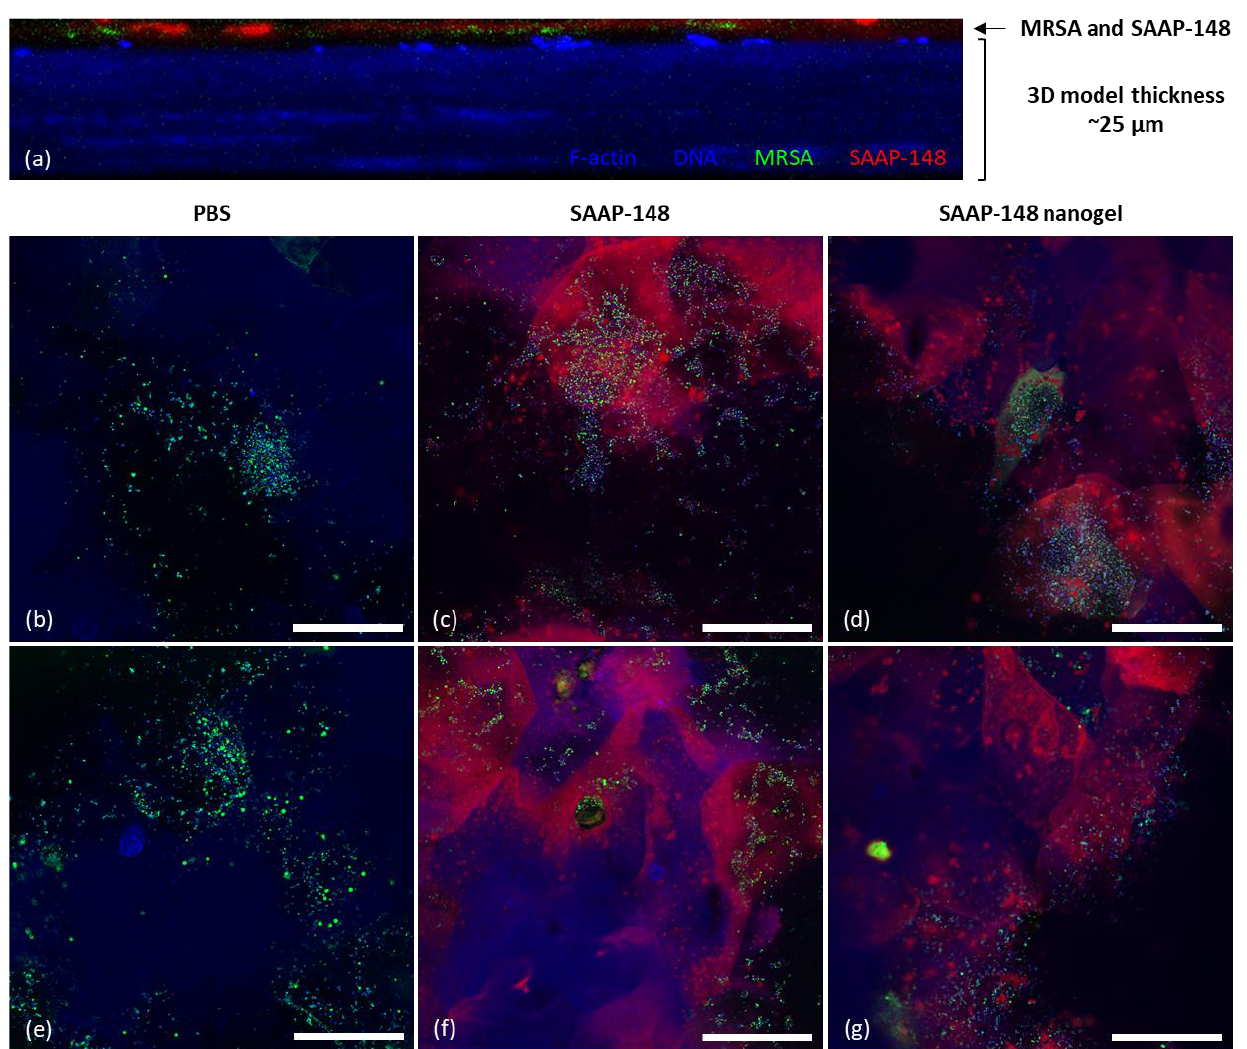
Figure 5. The penetration capabilities of TAMRA-SAAP-148-loaded nanogels compared to TAMRA-SAAP-148 in a 3D human epidermal model colonized with GFP-producing MRSA. Fluorescence confocal microscopy of a 3D human epidermal model colonized with GFP-producing MRSA (green) and treated for 4 h with 5 µM TAMRA-SAAP-148 (red) in PBS or 5 µM TAMRA-SAAP-148 nanogels (red) redispersed in PBS after lyophilization with 10 mg/mL PVA. Samples were stained for fila- mentous actin (F- actin) using Alexa Fluor 405 (blue) and with 4′,6 -diamidino-2-phenylindole (DAPI)